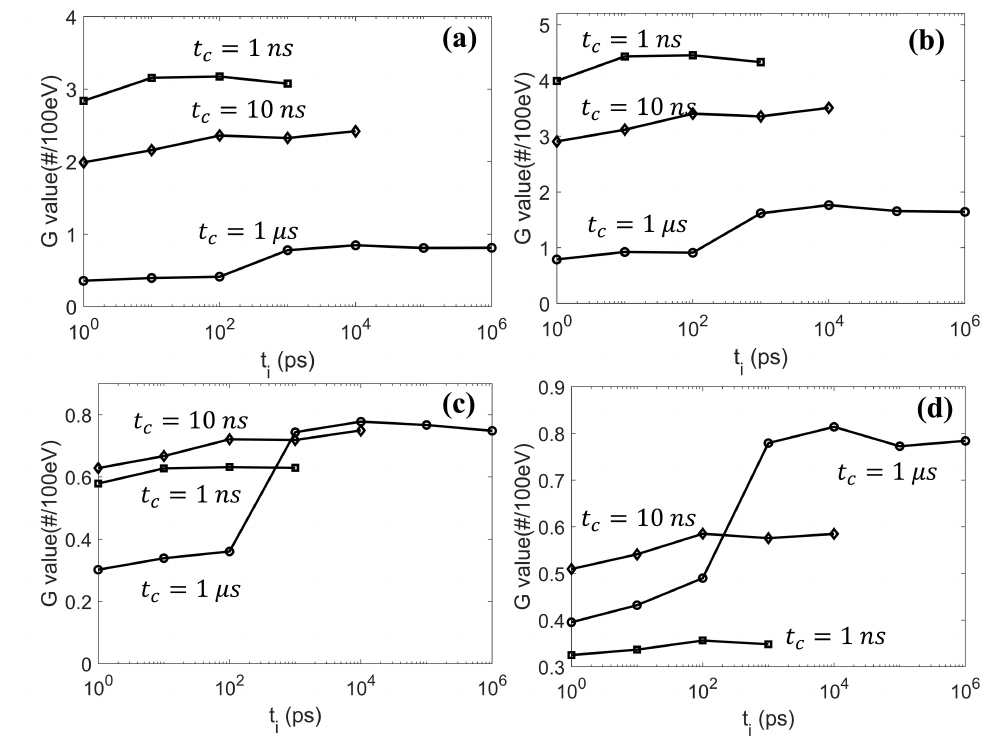
Figure 6. The yields of ( a ) e h , ( b ) OH · , ( c ) H · , and ( d ) H 2 O 2 chemical species at different checking time intervals t i and chemical stage durations t c